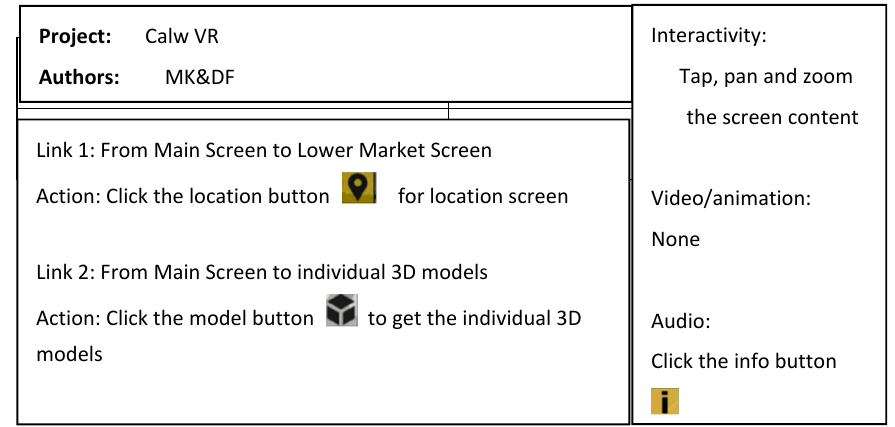
Figure 4. Excerpt of the storyboard’s main menu of the Calw VR App.